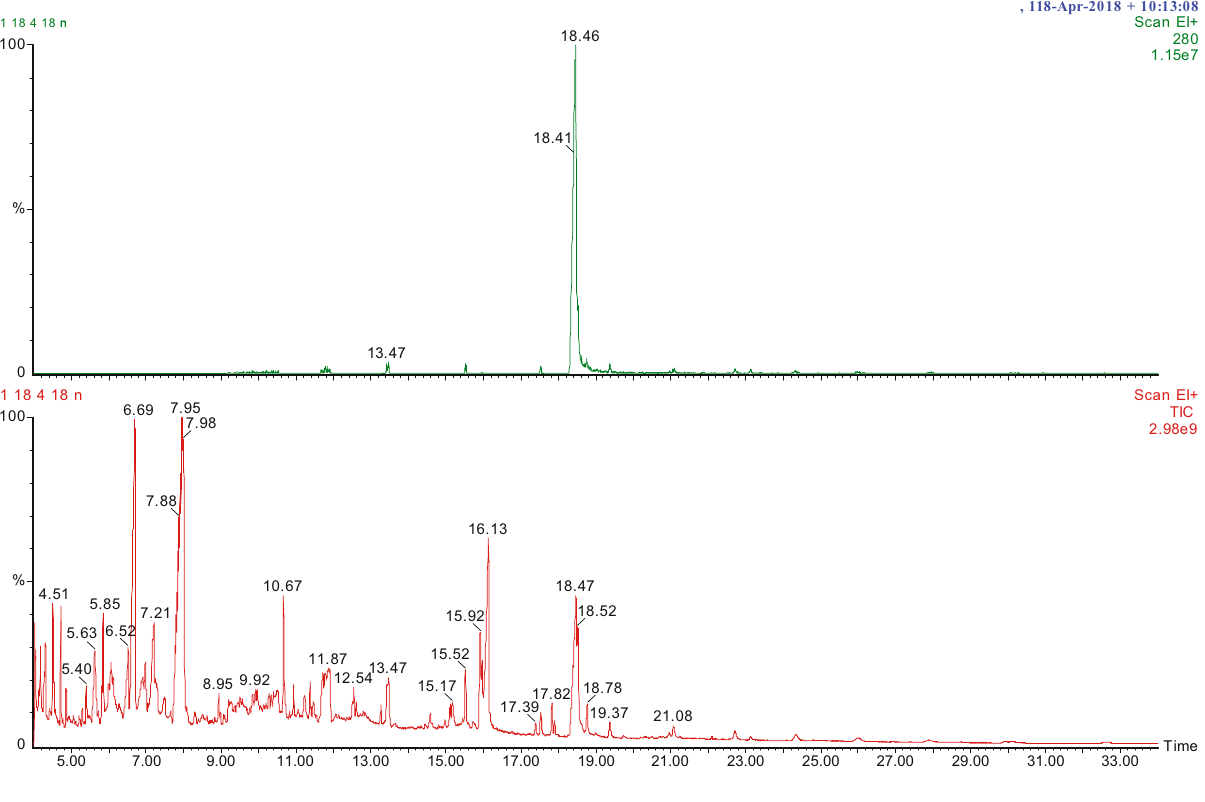
Figure 1: GC - MS spectrum of the Z. mays silk extract.